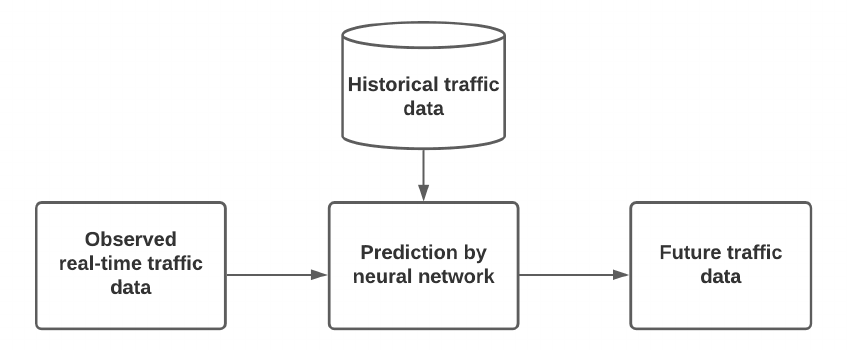
Figure 3. General block diagram of an NN-based traffic state prediction model (adapted from Do et al.